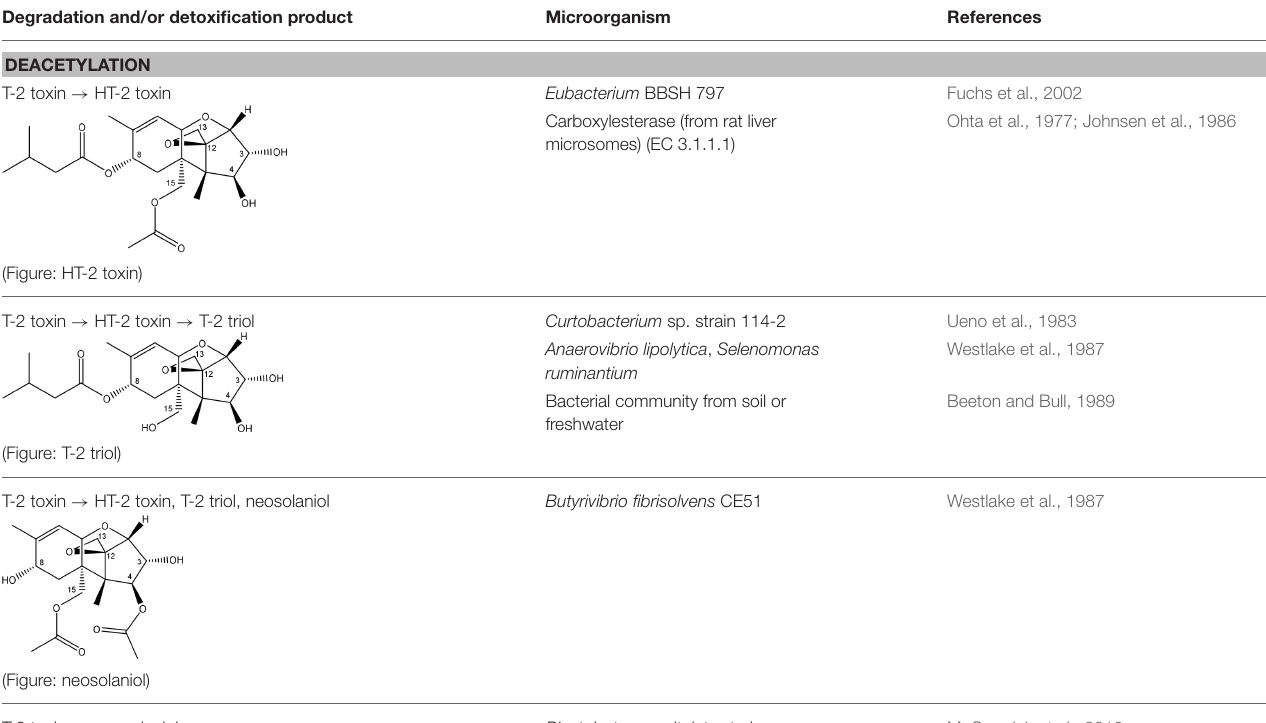
(Figure: neosolaniol) T-2 toxin → neosolaniol Blastobotrys capitulata strain Diacetoxyscirpenol → monoacetoxyscirpenol and scirpentriol Fecal microflora from chickens, horses or